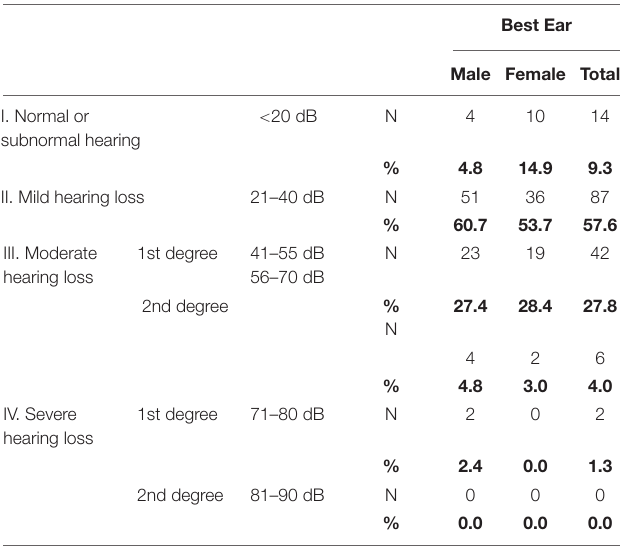
TABLE 4 | The BIAP classification of hearing impairment in the best- and worse hearing ear.